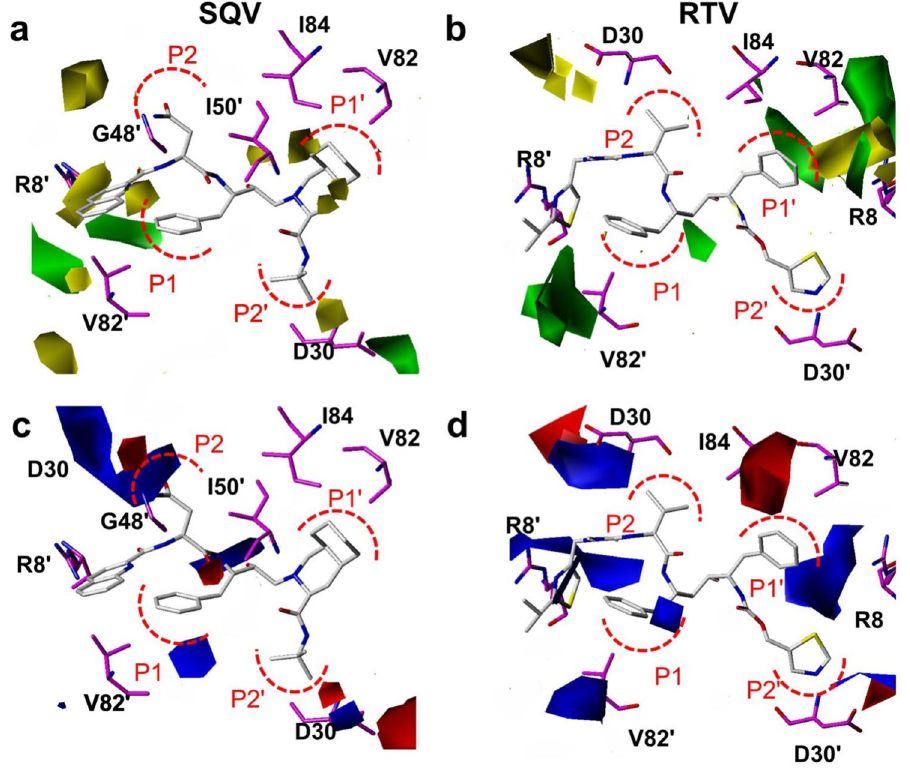
Figure 4. MB-QSAR/CoMFA contour maps of steric (upper panel) and electrostatic (lower panel) fields for SQV and RTV. PIs and representative residues of HIV-1 PR are shown in white and magenta sticks, respectively. Amino acids of HIV PR labeled with apostrophes belonging to another monomer with respect to the ones without apostrophes. Steric effect maps indicated areas where steric interaction was predicted to increase (green) or decrease (yellow) the potency of the p K i values for these inhibitors. Electrostatic effect maps indicated where high charge density (negative charge, red) and low charge density (positive charge, blue) regions were expected to increase the potency of the p K i values for these